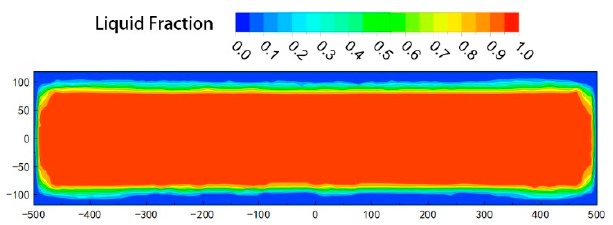
Figure 12. The contour of the liquid fraction at the outlet of the mold.